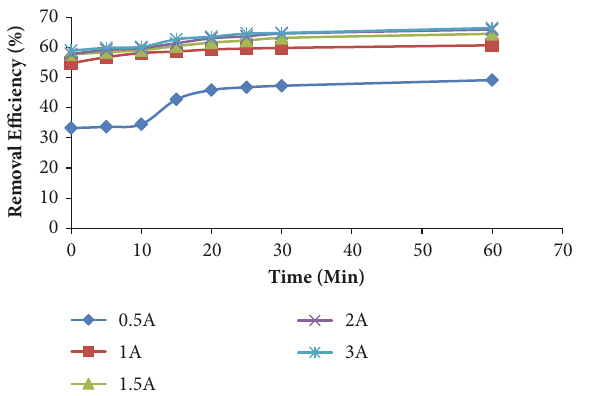
Figure 4: Effect of time and current densities, for POME at 30 ∘ C and pH of 10.